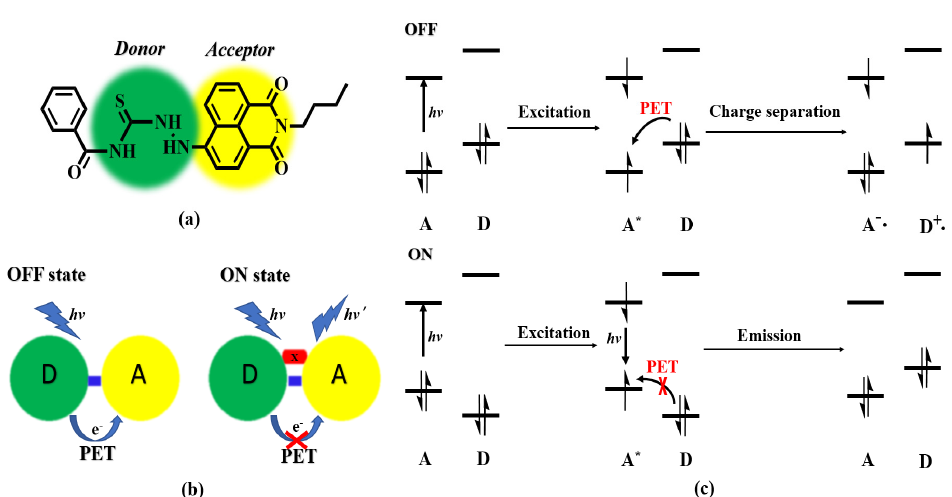
Figure 9. Frontier molecular orbital of ( a ) the L probe and ( b ) L -Co 2+ .